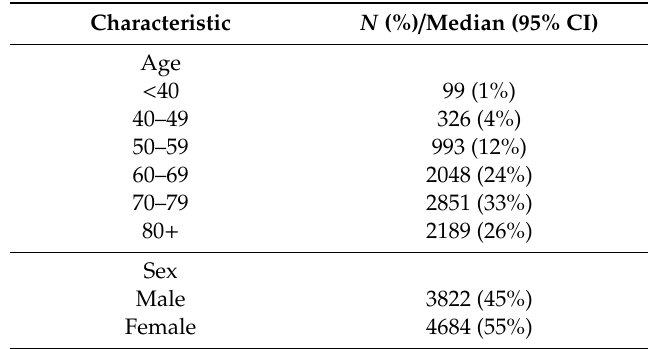
Table 2. Baseline characteristics of patients with BTC in the Netherlands